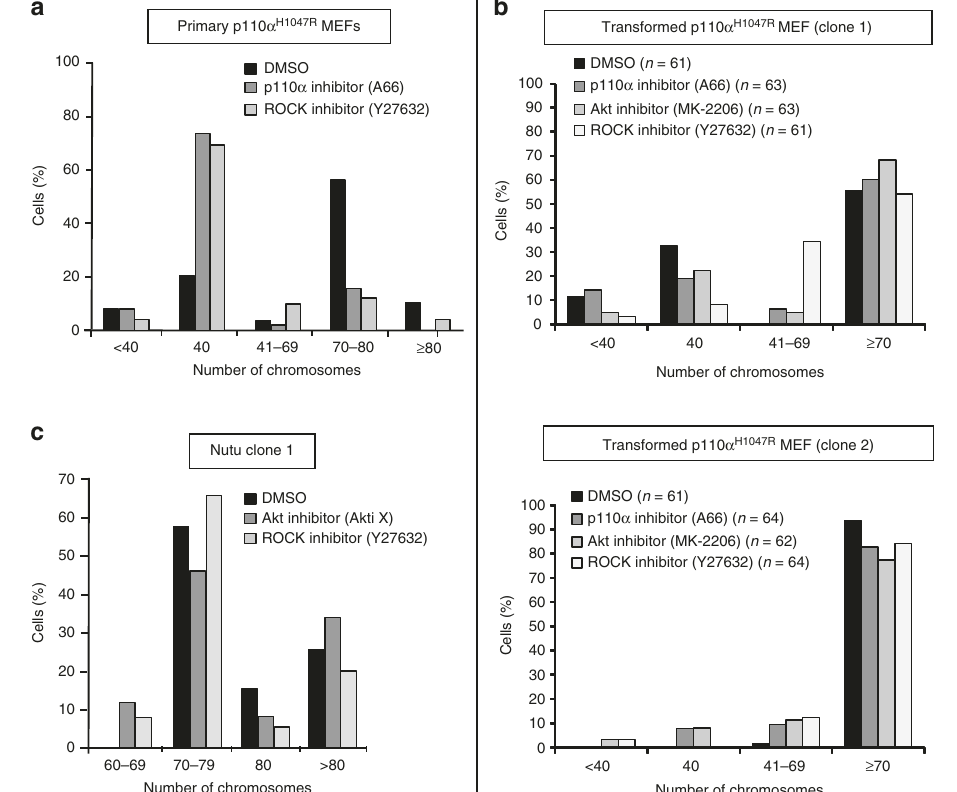
Fig. 8 Impact of pharmacological blockade of PI3K pathway components on tetraploidization in primary and tumour-derived MEFs. a Impact of inhibition of p110 α (by 3 µ M A66) or ROCK (by 10 µ M Y27632) on p110 α H1047R -induced chromosomal abnormalities in primary MEFs. One Pik3ca H1047R+neo ; Flpe-ER T2 MEF line was analyzed and at least 50 metaphase spreads were counted per condition. Inhibitors were added together with the 4-OHT to induce p110 α H1047R expression. b Impact of 14 day inhibition of p110 α (by 3 µ M A66), Akt (by 1 µ M MK-2206) or ROCK (by 10 µ M Y27632) on